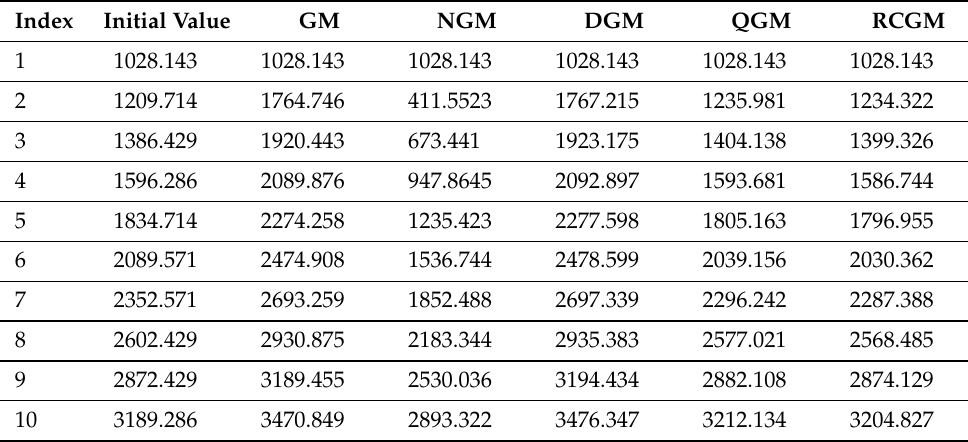
Table 6. Predicted values from Maharashtra data Model